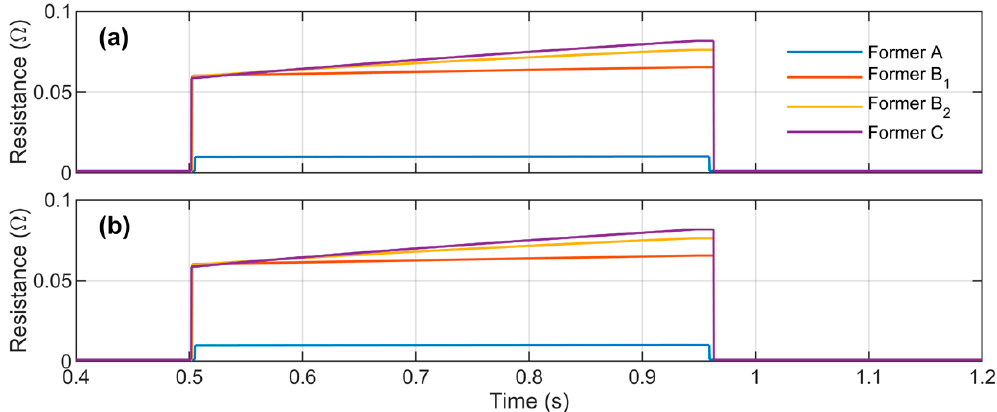
Figure 28. HTS cable resistances in case DCR and DOCR fail: ( a ) HTS 1 ; ( b ) HTS 2 .